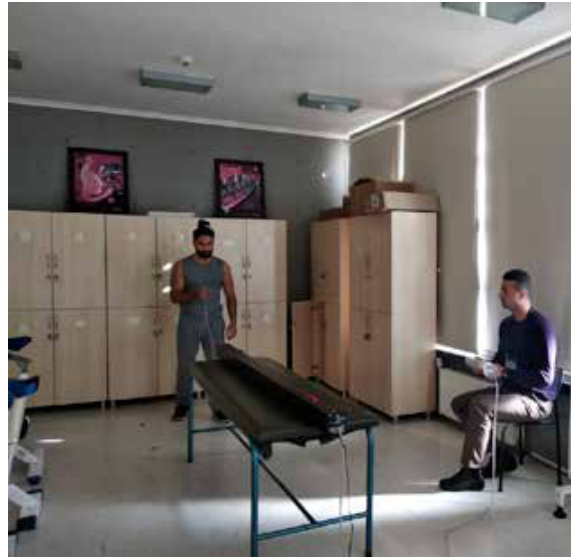
Figure 1. The CAT performance measurement Absolute error score: It is a measure of timing error, which is frequently used in studies related to CAT performance. The absolute error gives information about the magnitude of the error made by the participant during the trial, and trial series. It also expresses the absolute value of each raw score obtained as a result of the measurement, regardless of whether the response is early or late, and explains the individual and combined effects of task characteristics as a whole. The score obtained shows the general accuracy index of an individual’s performance A high score indicates that more errors were made during the trial or trials [44, 47,